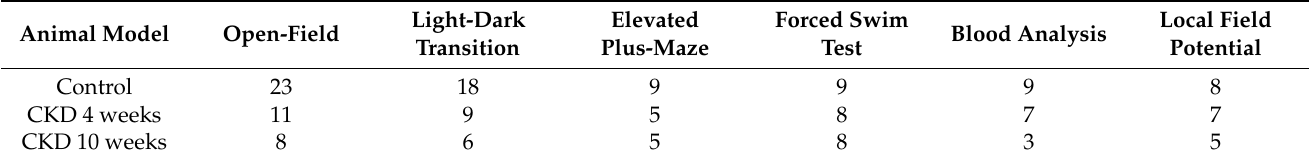
Table 1. Number of tested animals in each behavioral